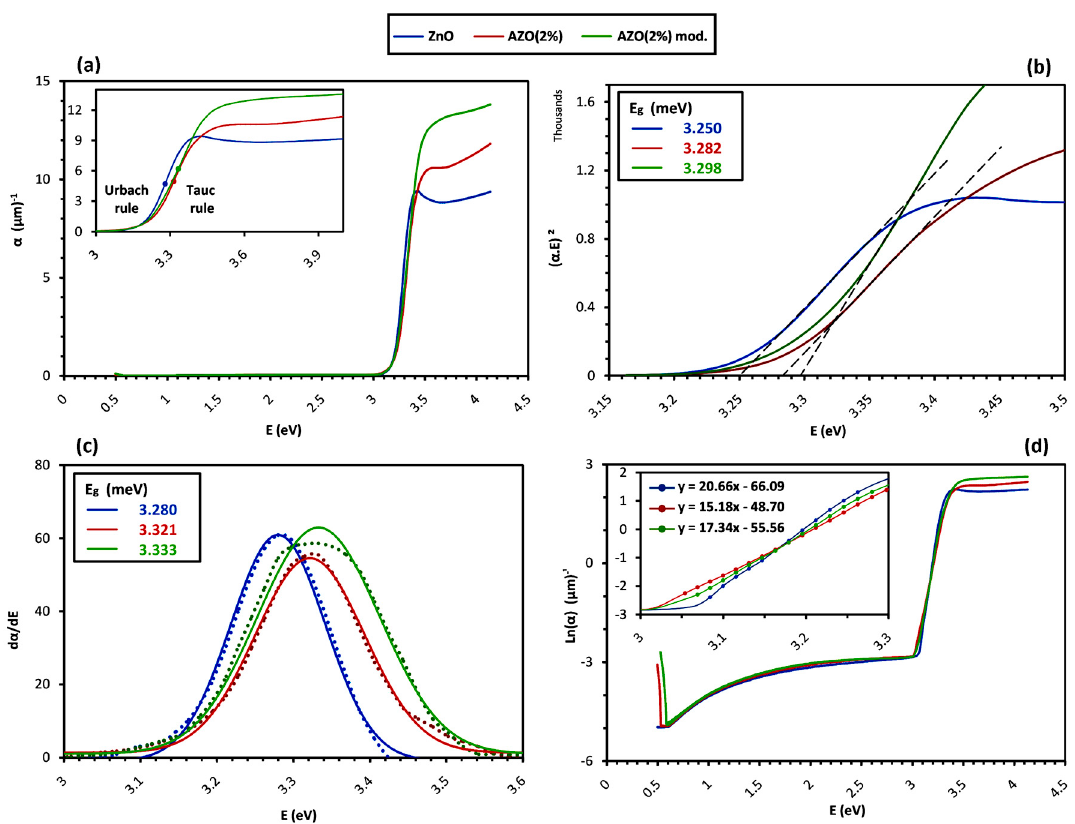
Figure 6. ( a ) The plot of α ( µ m − 1 ) versus h ν . The inset is the magnification of the high-energy part, and shows the regions governed by Tauc and Urbach rules. The band-gap energies are marked with solid dots. ( b ) Determination of the band-gap energies via the Tauc-plot method; and ( c ) the alternative method to find the band-gap using the maximum of the d α / d(h ν ) curve (dotted curves). The solid curves show the Gaussian fits for d α / d(h ν ) curves. ( d ) The plot of Ln( α ) ( µ m − 1 ) versus h ν . The inset shows the magnification of the linear parts. The slopes indicate E u values reciprocally.